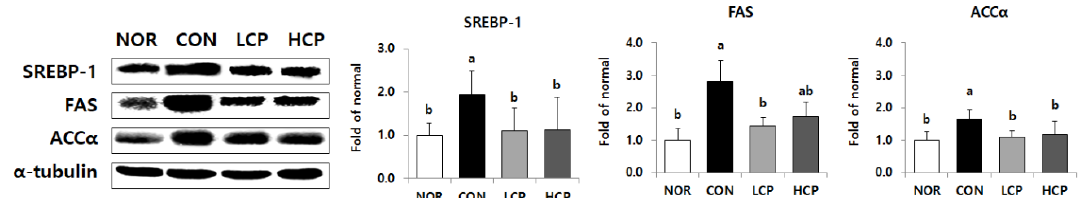
Figure 4. Effects of two skate skin-derived collagen peptides with different molecular weights on hepatic protein expression of fatty acid synthesis. Data are mean ± standard deviation (SD) ( n = 10 per group). Experimental groups were divided into four groups; m/m mice were orally administered water as a vehicle (NOR group) whereas db/db mice were orally administered water (control group, CON), LCP (LCP group), or HCP (HCP group) at a dose of 200 mg·kg bw −1 ·day −1 for 8 weeks. a,b Different letters mean significant differences to one-way analysis of variance (ANOVA), followed by Duncan’s multiple-range test at p < 0.05.